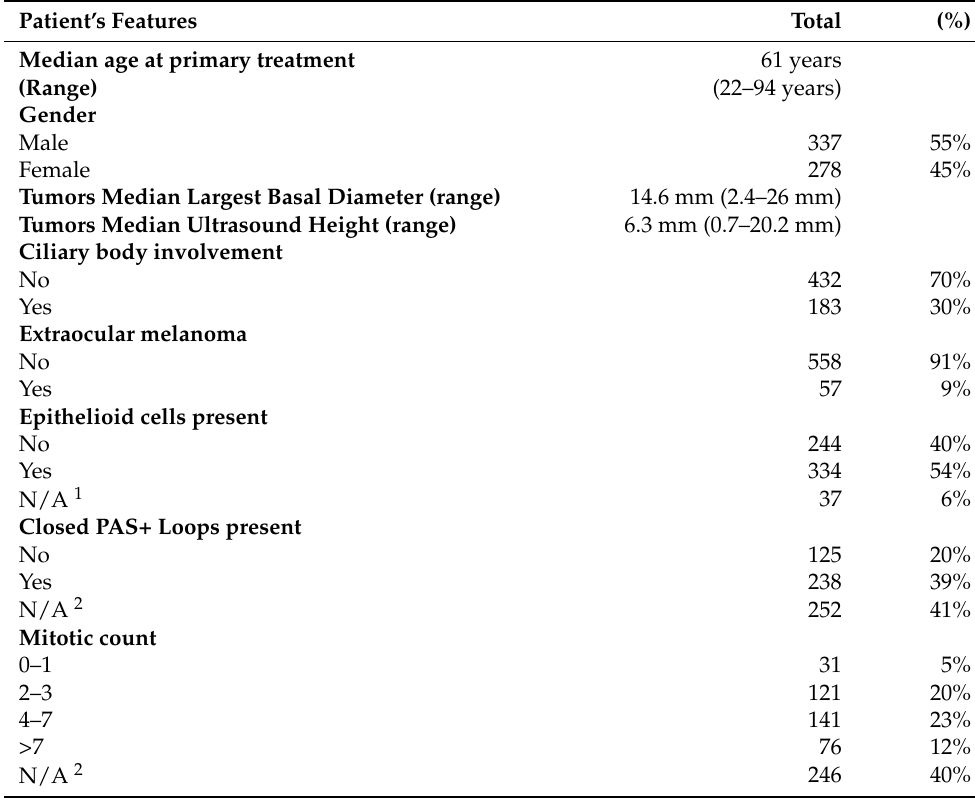
Table 1. Patient’s Characteristics, overall data